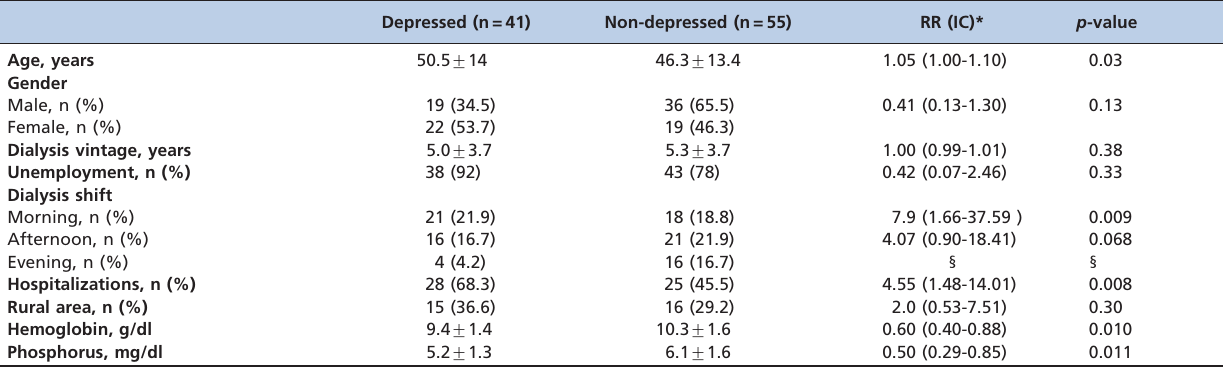
Table 3 - Independent risk factors for depression (logistic